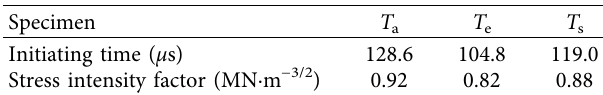
Table 3: The initiating time and corresponding stress intensity factor at the upper edge of the rectangular